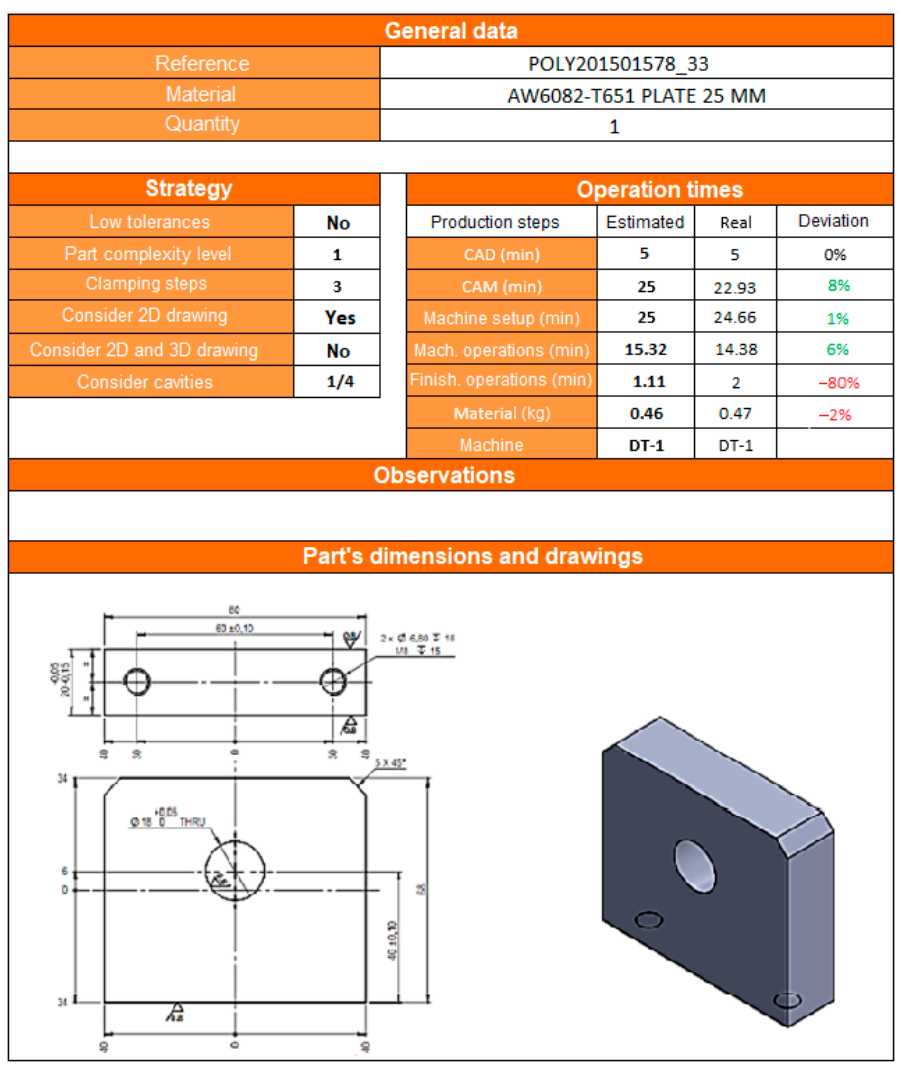
Figure 9. Output sheet of a machined aluminum part, with low complexity level.